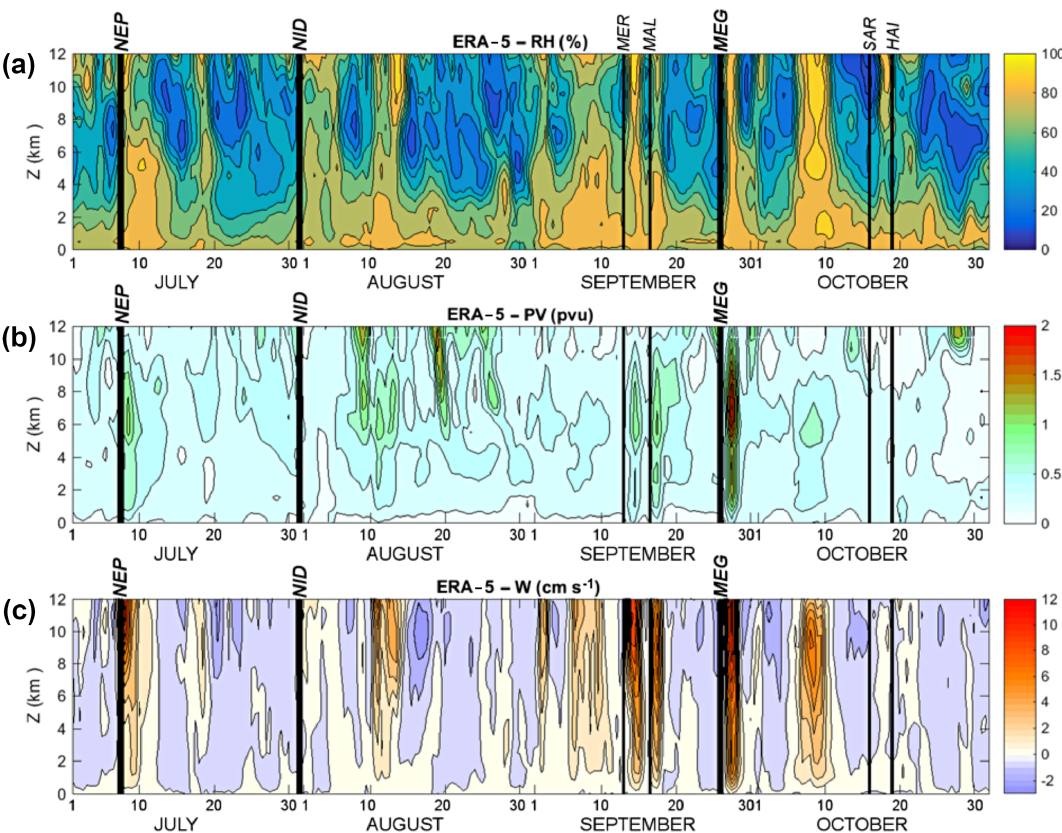
Figure 3. As in Fig. 2, except for vertical profiles derived from ERA-5 reanalyses within 300km of TPE from 1 July to 31 October 2016 for (a) mean relative humidity (in %), (b) mean potential vorticity (in potential vorticity units; 1PVU = 10 − 6 m 2 s − 1 Kkg − 1 ) and (c) mean vertical velocity (in cms − 1